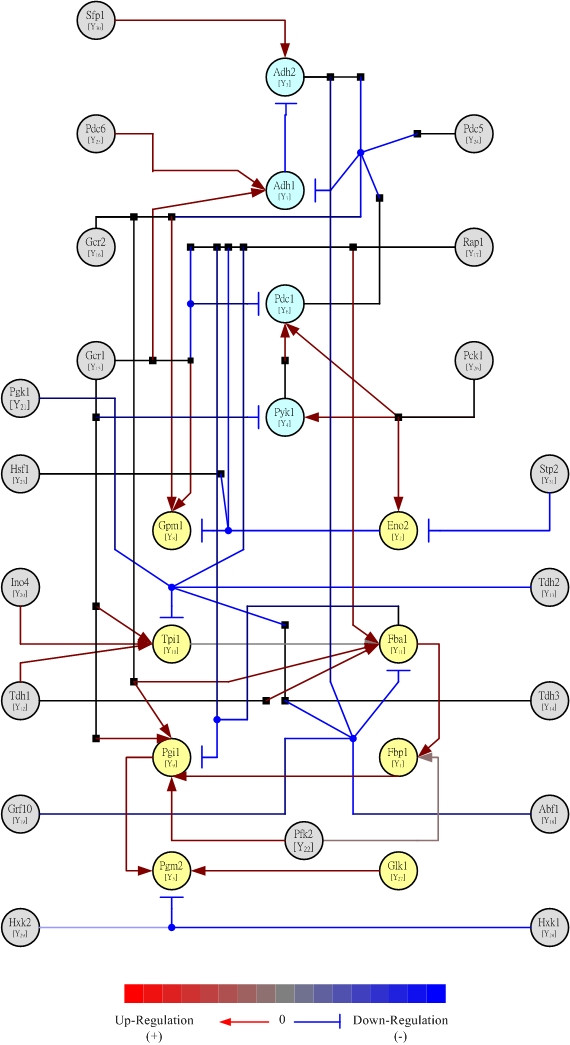
The pathway of metabolic shift regulatory system of yeast Saccharomyces cerevisiae in Fig. 6 is repeated as independent validation by randomly reshuffling the time order of microarray experiment but with the same choices of target and regulatory genes. Obviously, the proposed pathway in Fig. 6 is destroyed by the reshuffling of experimental data. The related genes are represented as ovals with different colors of light blue (fermentation), light yellow (gluconeogenesis), and gray (other relevant genes not as target genes). There are three types of lines with colors of red (activation), blue (repression), and black. In addition to the black line representing the signal pipes from genes, the red lines are shown depending on the degree of activation whilst the blue lines are shown depending on the degree of repression. The black square symbol attached on the lines is the bifurcate node from the same signal source. And the circle symbol attached on the lines is the collecting nodes from different signal sources. The colored degree bar between activation and repression is also shown in the bottom of the figure.